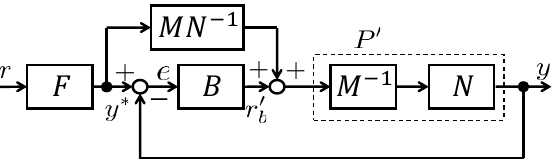
Figure 10. Proposed tracking